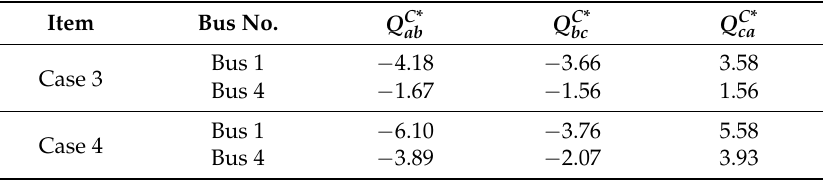
Table 6. Compensation commands of